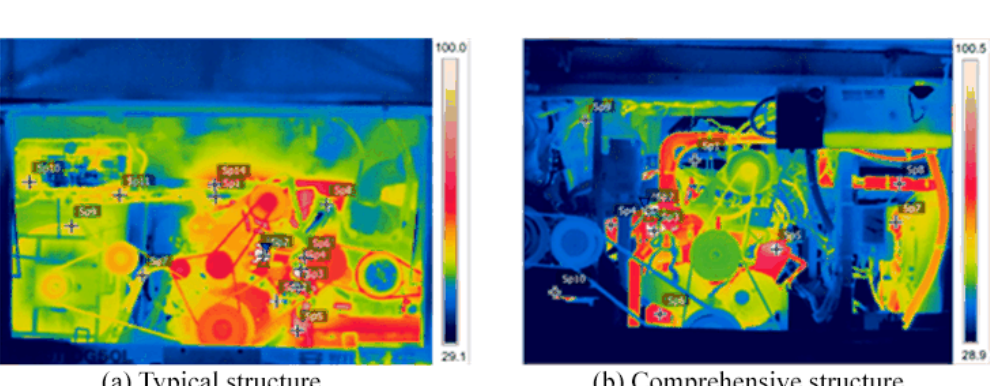
Figure 15. LPGB for experiment.